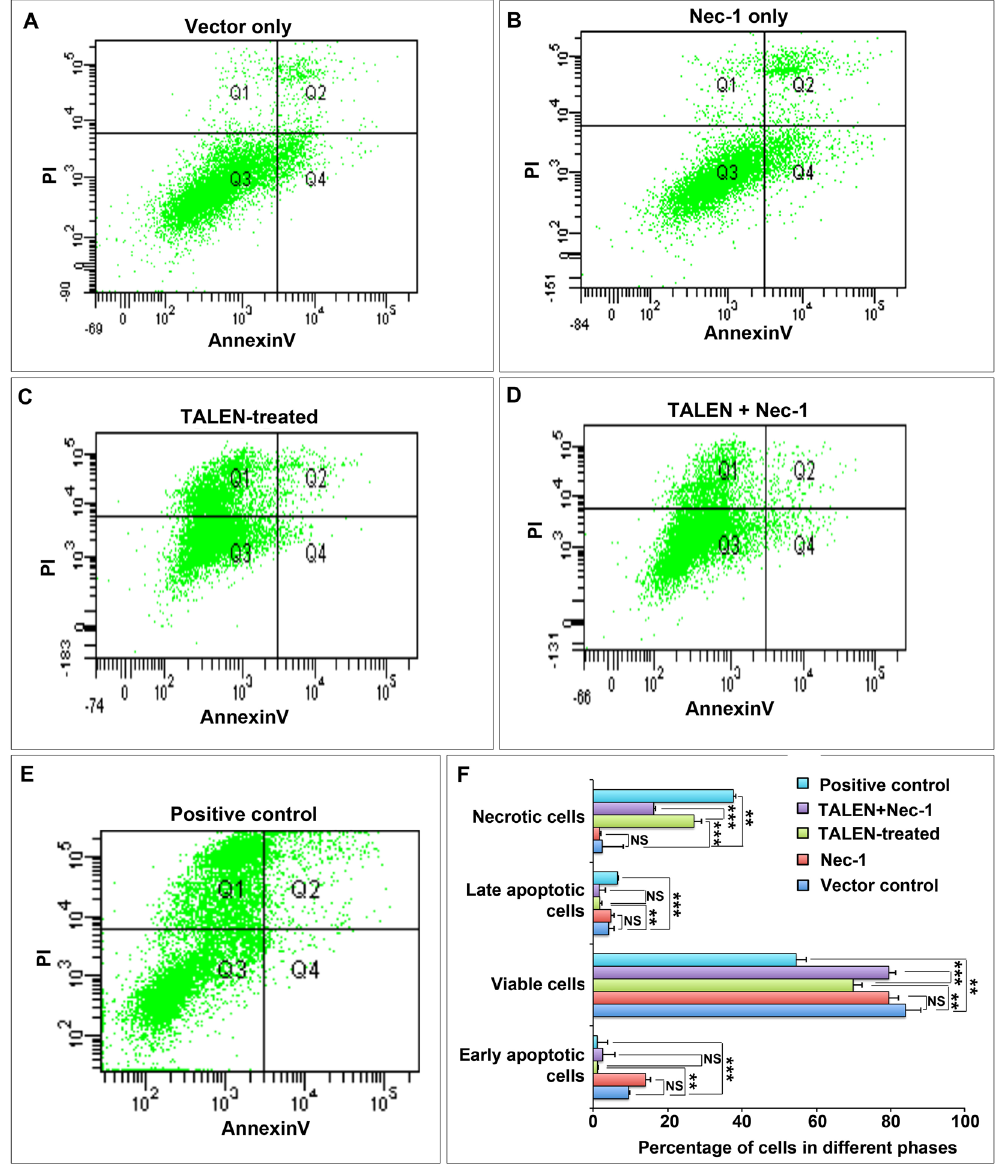
Figure 6. Inhibition of Necrotic cell death in TALEN treated cells by Necrostatin-1. In order to confirm the cell death due to necrosis, we transfected SiHa cells with TALENs and exposed to 50 μ M Nec-1 and Annexin V assay was performed using FACS. Annexin V FACS profile of vector alone control ( A ), Nec-1 alone ( B ), TALEN- treated ( C ), TALEN + Nec-1 ( D ) and H 2 O 2 -treated positive controls ( E ). Graph represents the percentage of cells in various phases. Data are expressed as mean ± SD from triplicates of three different experiments. NS-not significant, ** P < 0.001, *** P <